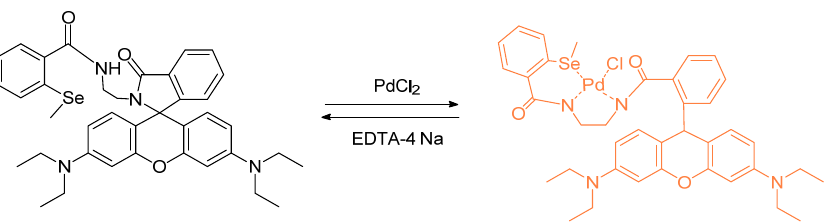
Figure 11. Chemical structure and reactivity of the rhodamine–containing selenide ( Rh – Se ) system designed for Pd 2+ binding and recognition by Soares–Paulino et al.